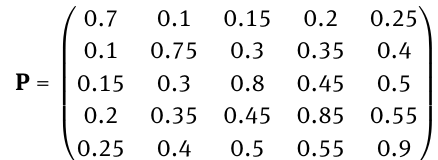
Figure 2: Generalized quasirandom graph constructed with k = 5 , clus- ter sizes 60, 80, 100, 120, 140 and probability matrix P below. The first non-trivial eigenvalues of A D are 0.318, 0.207, 0.154, 0.115, − 0.100, −0.099, −0.091, − 0.090, 0.084, . . . , exhibiting decreasing eigenvalues up to the 4th one.